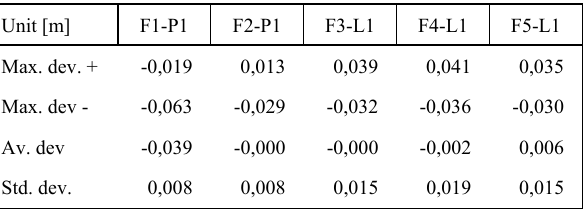
Table 3 . Deviations (  Z) of 3D point clouds at 44 check points for flight 1-5 and P1 and L1.